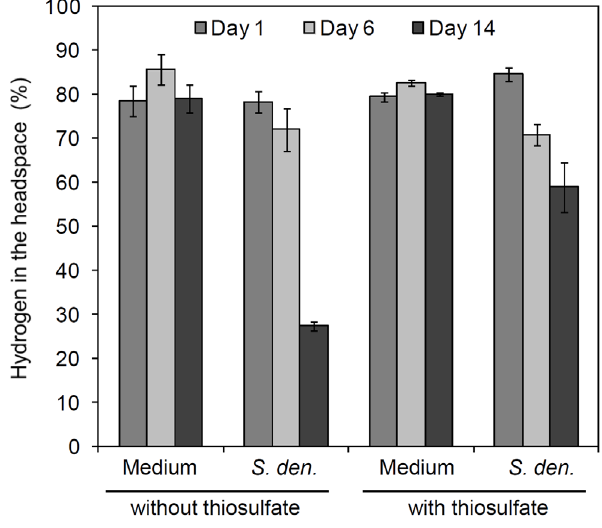
Figure 2. Invivo hydrogen consumption in S.denitrificans DSM- 1251. S. denitrificans DSM-1251 cells were grown anaerobically in DSMZ medium 113 either with thiosulfate (18.8 mM) or without thiosulfate. On the first day of inoculation, the headspace of each sample was exchanged with H 2 /CO 2 (80%/20%). The H 2 concentration in the headspace was measured with gas chromatography. A control experiment was set up to exclude hydrogen leakage from the vessels. Medium=control, medium without inoculated S. denitrificans DSM- 1251; S. den. =inoculation with 0.5 mL of S. denitrificans DSM-1251 pre- culture at day 1. Error bars of ‘‘Medium’’ and ‘‘ S. den. ’’ indicate the standard deviations from three independent experiments.